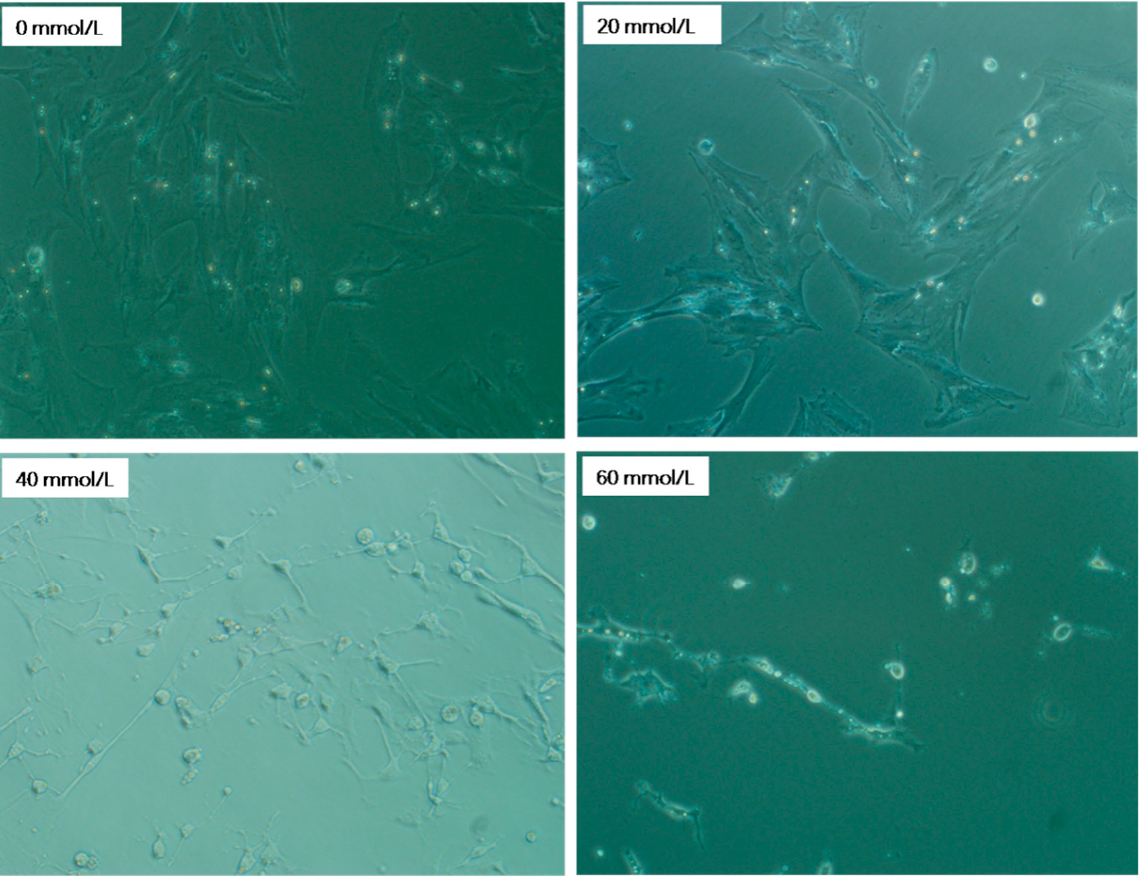
Figure 1. Cell morphology observed by fluorescence microscopy. The granulosa cells of the porcine ovary (pGCs) were exposed to various concentrations of 2,5-HD (0 mmol/L, 20 mmol/L, 40 mmol/L and 60 mmol/L) for 24 h. Scale bar 200µm.